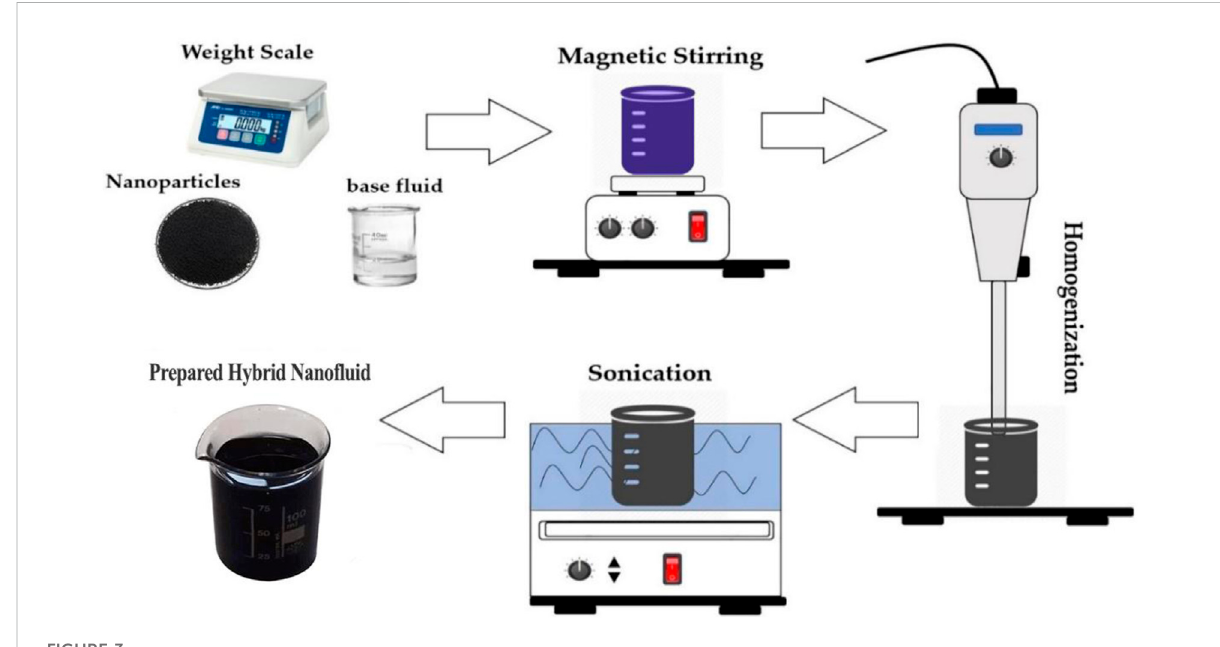
FIGURE 3 Schematic diagram of NFs and hybrid NFs.